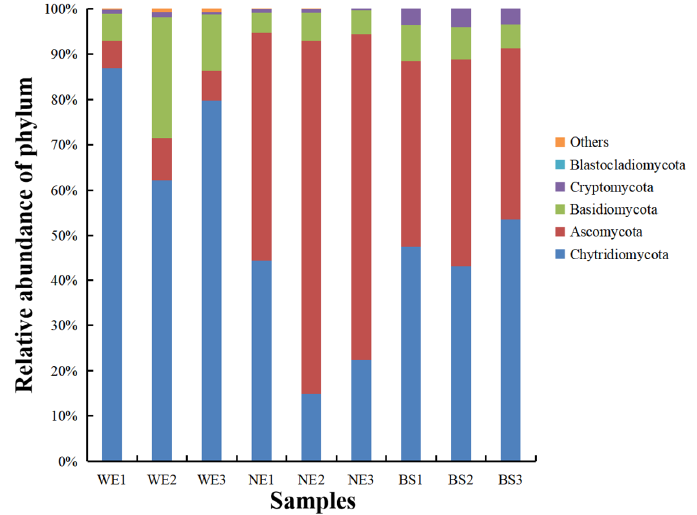
Figure 4. Relative abundance of different fungal phyla in rhizospheric soils under different treat ‐ ments. WE refers to soil inoculated with ectomycorrhizal fungi, NE refers to soil inoculated without ectomycorrhizal fungi, and BS refers to bulk soil.